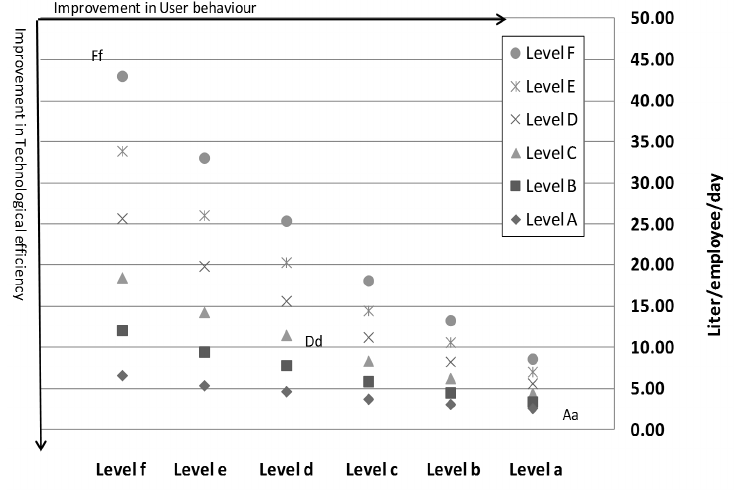
Figure 7. Office demands through behavioural and technological change (conventional